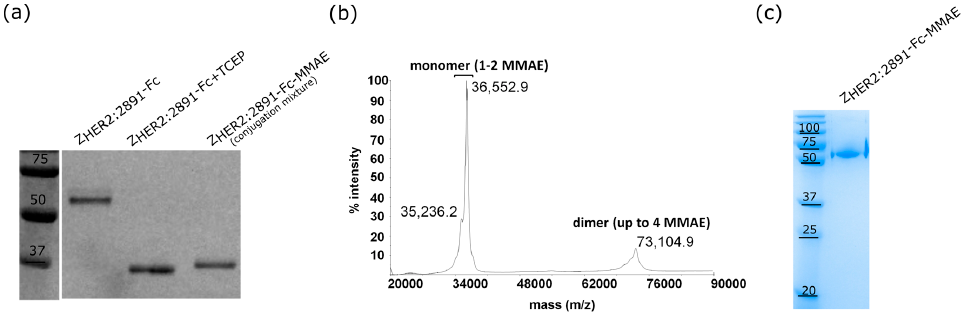
Figure 4. Conjugation of MMAE to Z HER2:2891 -Fc. ( a ) The Z HER2:2891 -Fc species before and after conjugation separated on 12% SDS-PAGE gel and subjected to Coomassie staining. The samples were heated (96 °C, 10 min) in non-reducing Laemmli buffer prior the electrophoretic separation; ( b ) The mass spectrum of the conjugation product; ( c ) The Z HER2:2891 -Fc-MMAE conjugate migration on a native 12% polyacrylamide gel under non-reducing conditions stained with Coomassie [45].